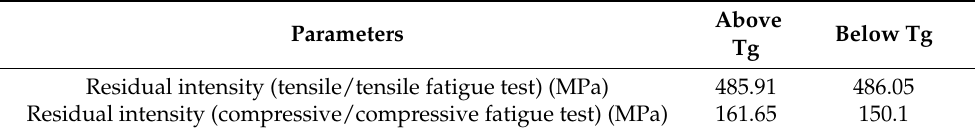
Table 3. Residual intensity of untreated and cryo-treated